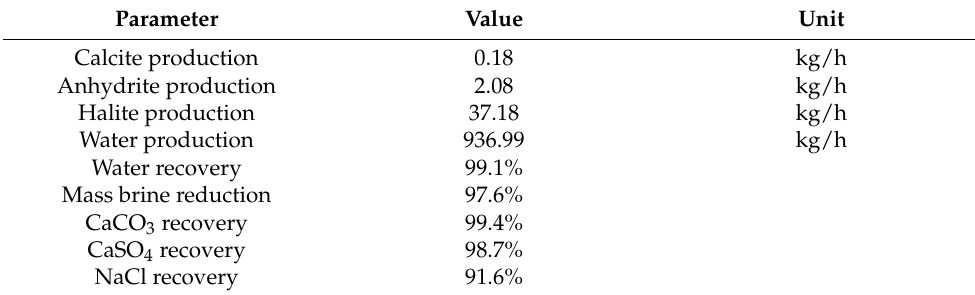
Table 12. Production results for the conventional ZLD system for 1000 kg/h of feed brine.